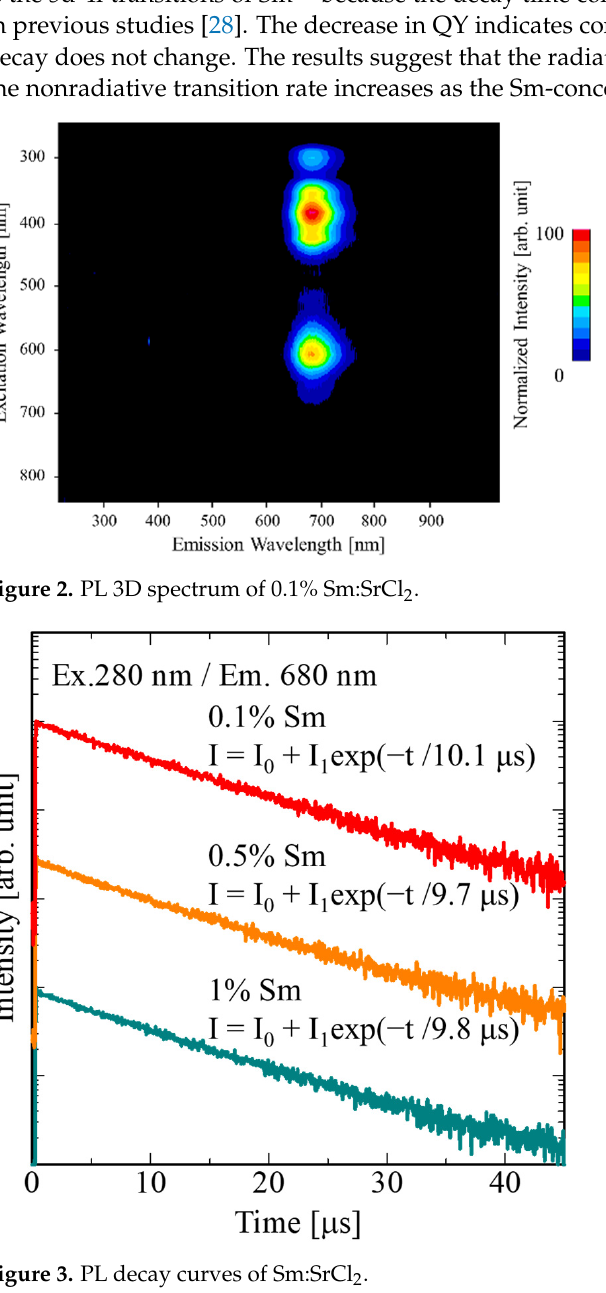
Figure 3. PL decay curves of Sm:SrCl 2 .